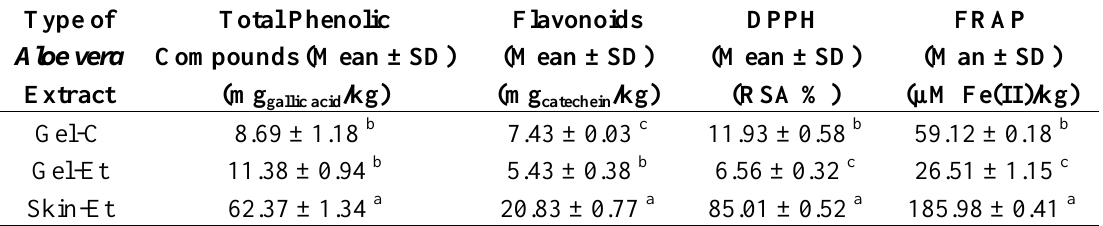
Table 1. Total phenolic and flavonoid contents, DPPH scavenging activities (%) and FRAP values of the different extracts of Aloe vera